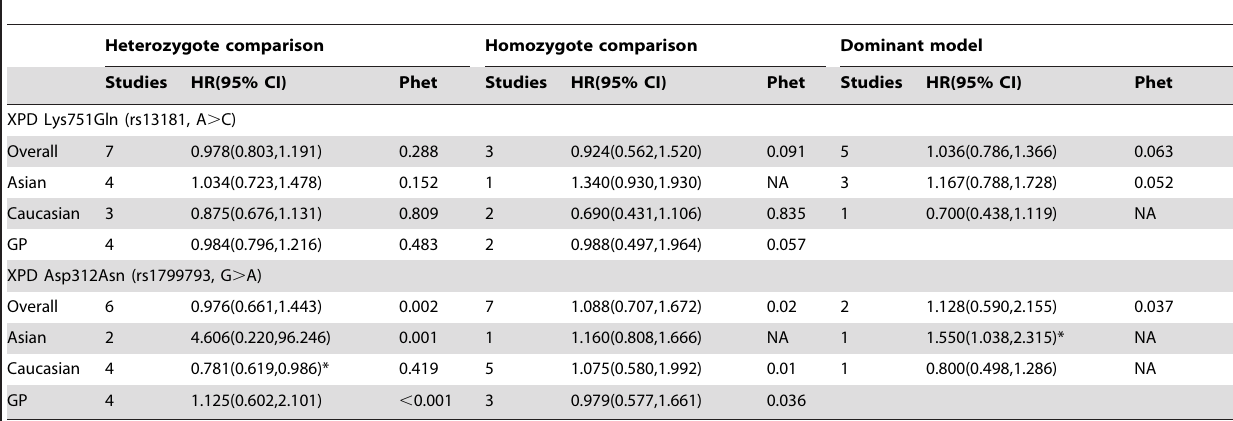
Table 3. Meta-analysis results about XPD polymorphisms and overall